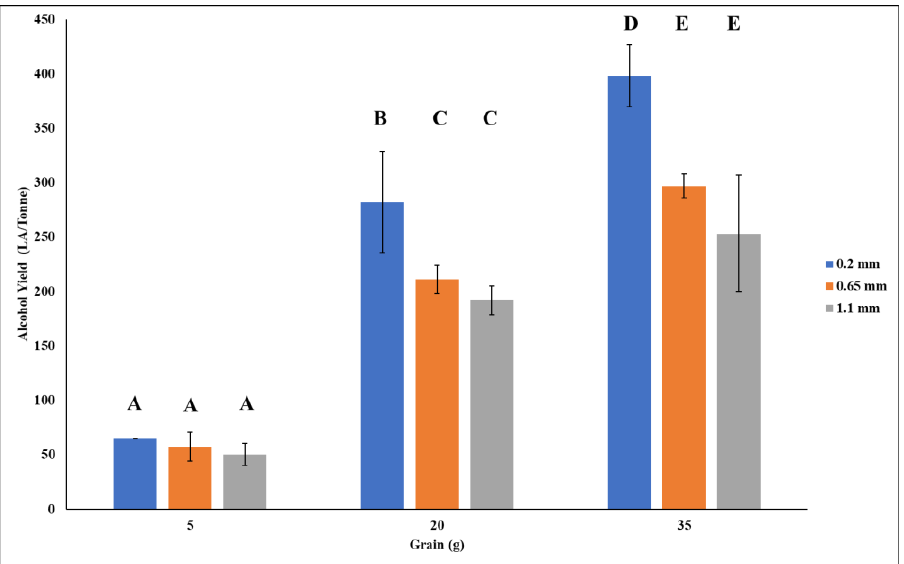
Figure 1. Mean alcohol yield achieved using different grain amounts and grain particle sizes. Results are presented as mean ( n = 3) and error bars indicating standard deviation. The same letter indicated no significant differences, as determine by one-way ANOVA with the Tukey post hoc test.